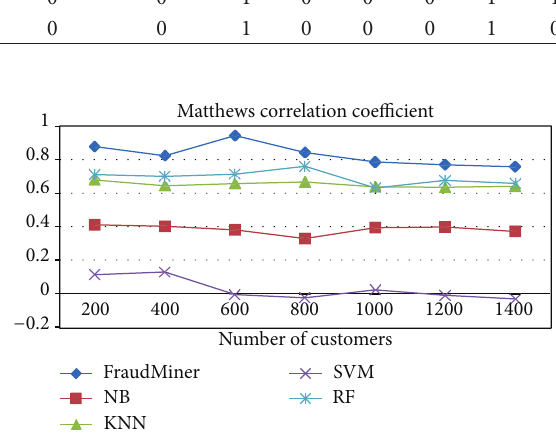
Figure 3: Performance comparison of classifiers on false alarm rate.